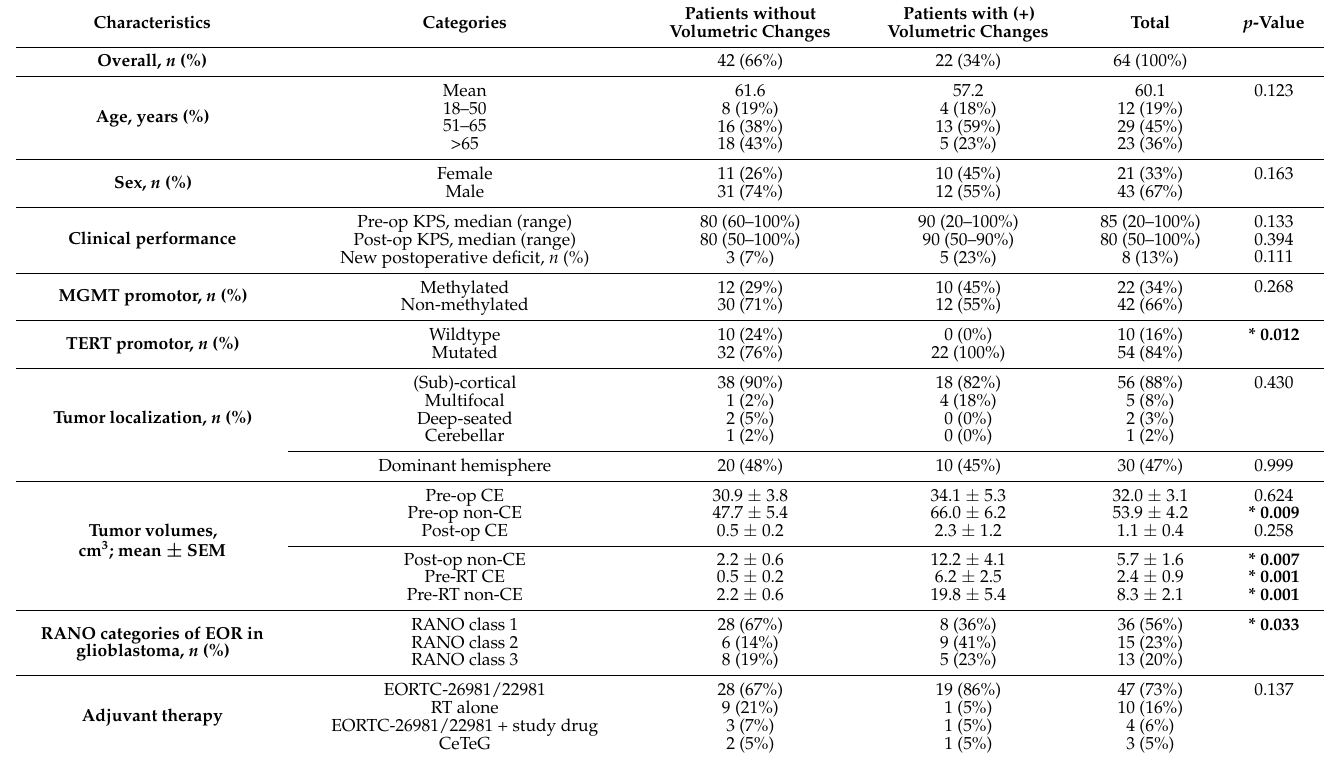
Table 1. Baseline characteristics for patients with glioblastoma, IDH-wildtype, CNS WHO grade